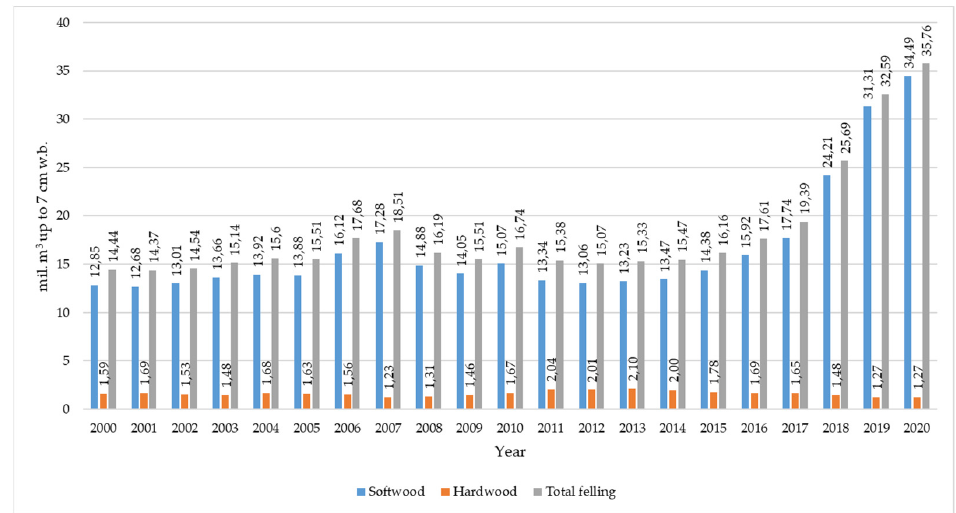
Figure 3. Development of total felling. Source: [49].